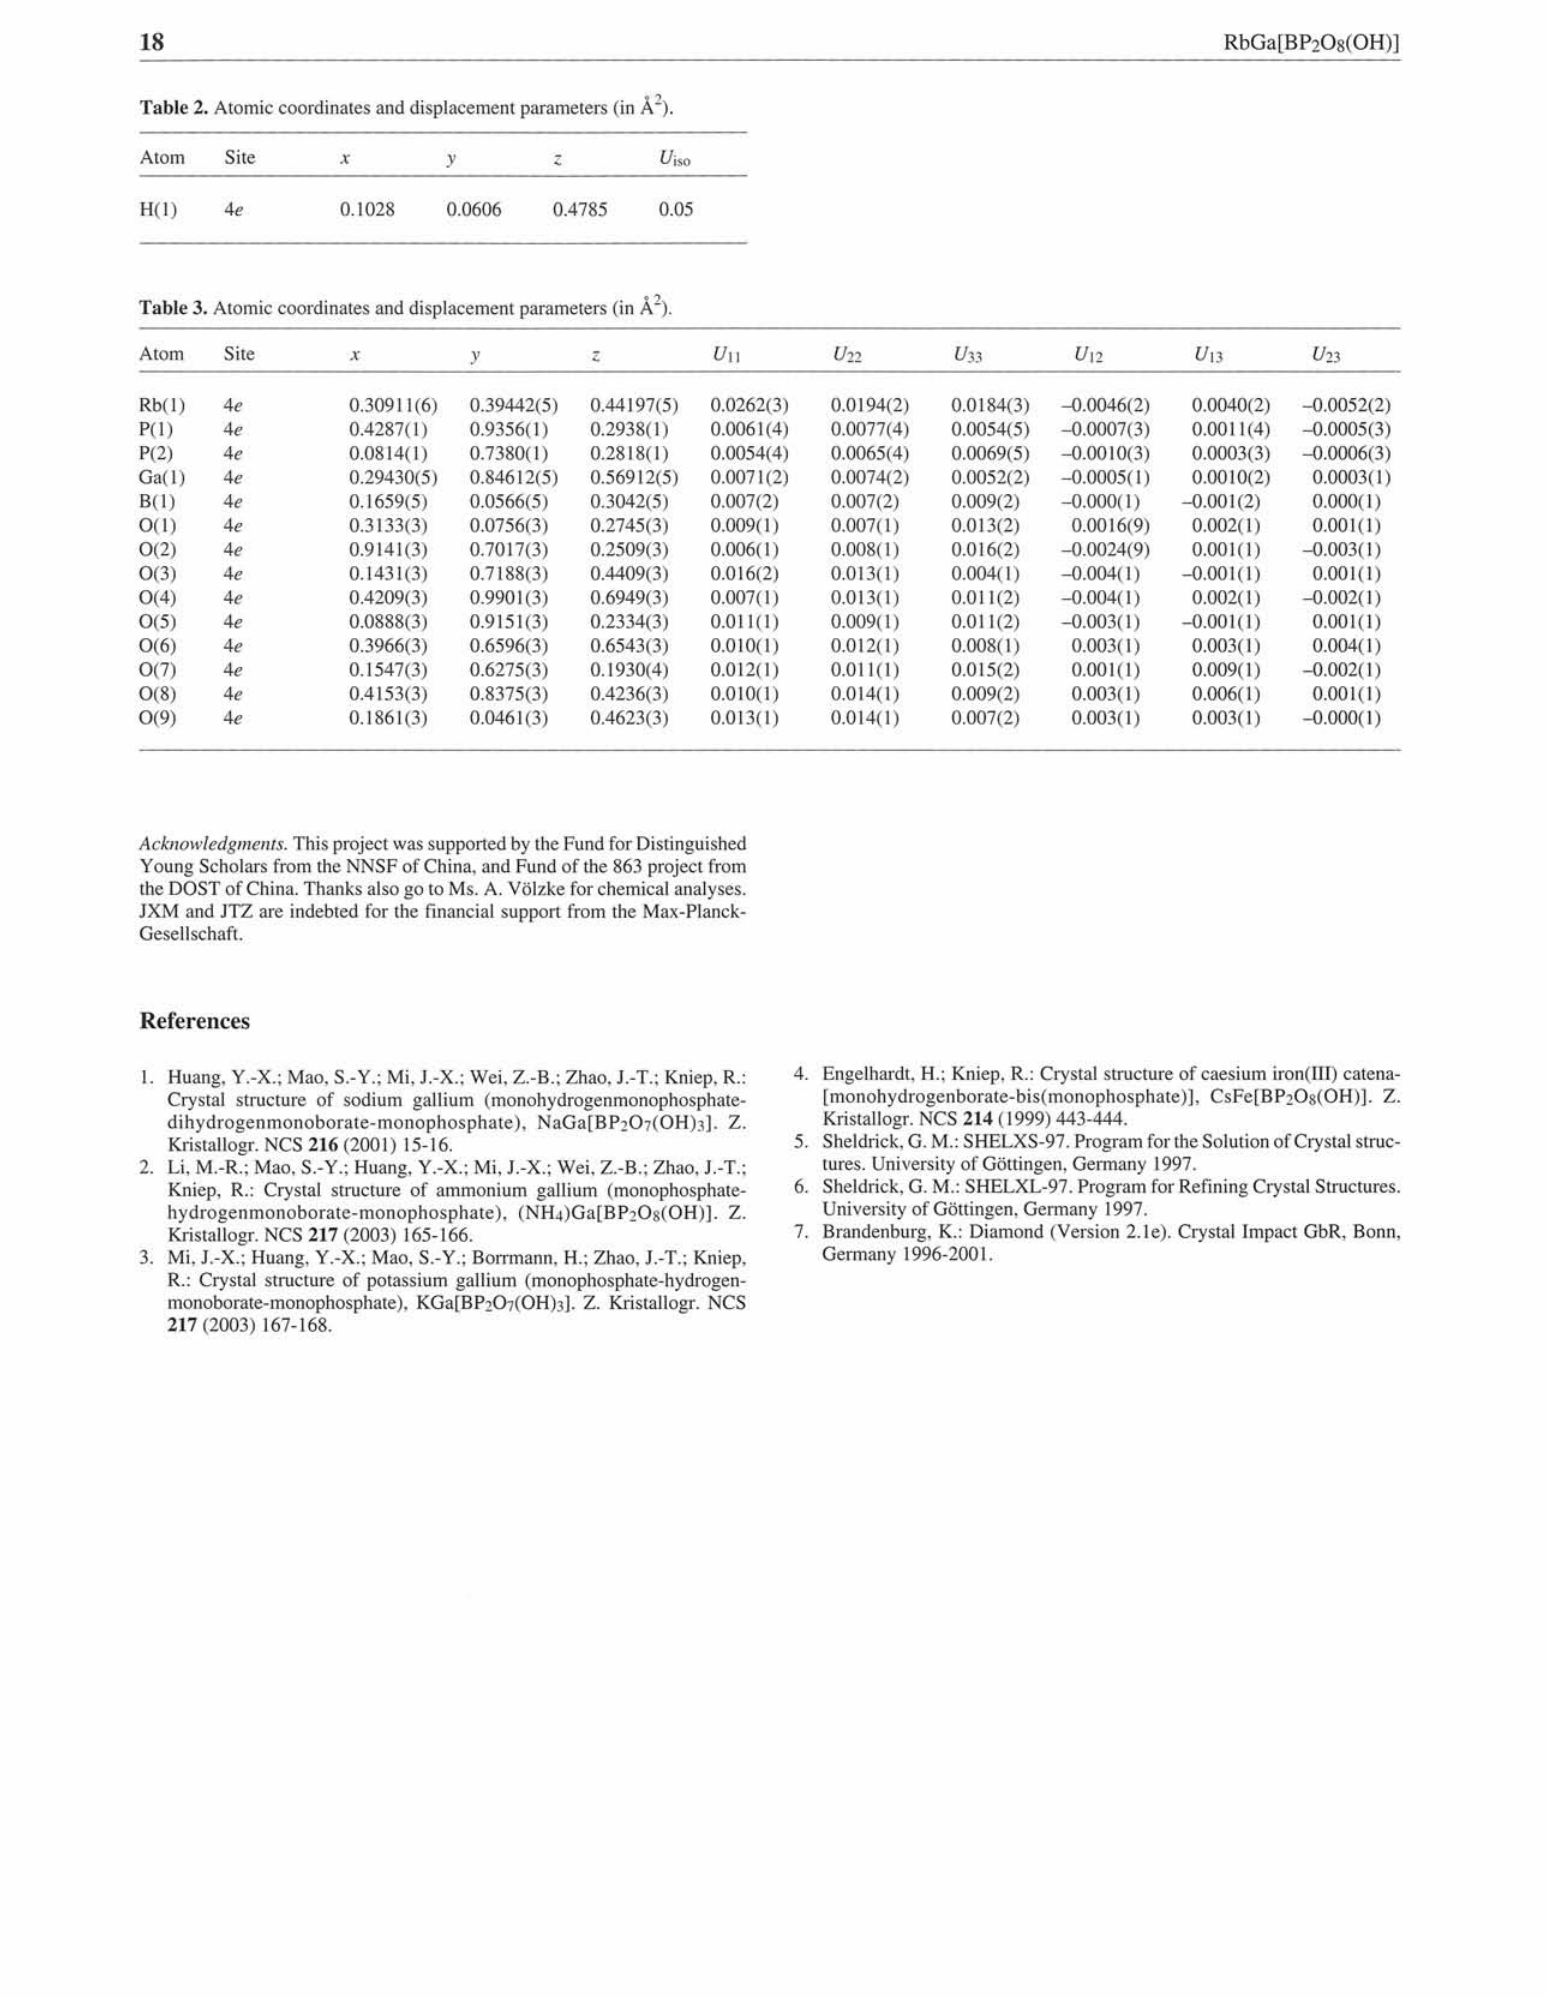
Table 3. Atomic coordinates and displacement parameters (in Â 2